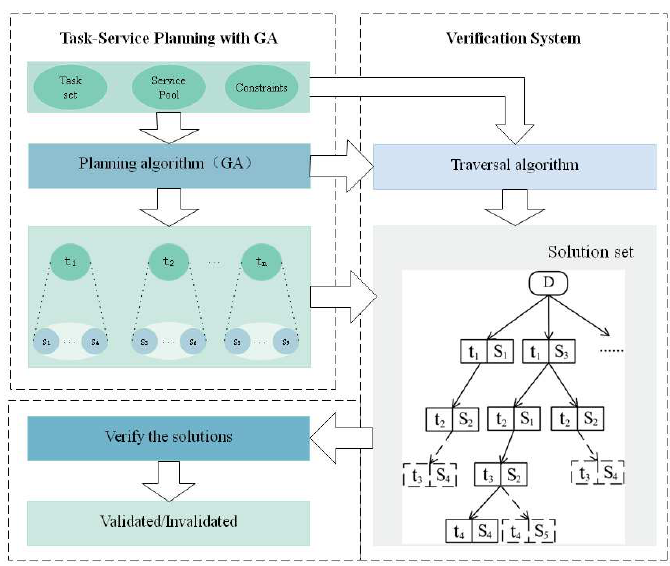
Figure 13. Verification Architecture with a Traversal